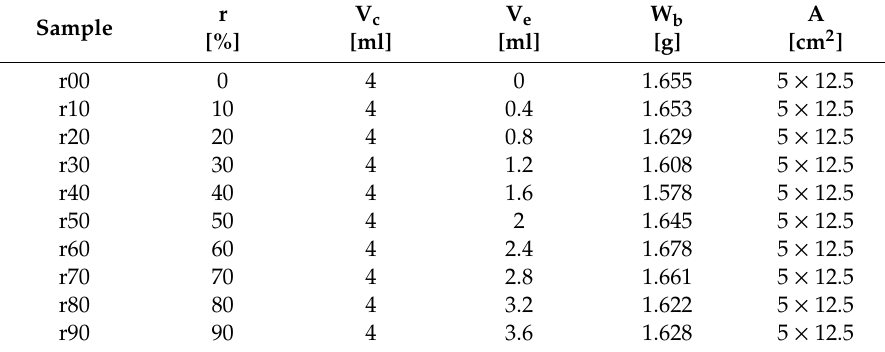
Table 1. Mix ratios of the conductive polymer composite and weight before